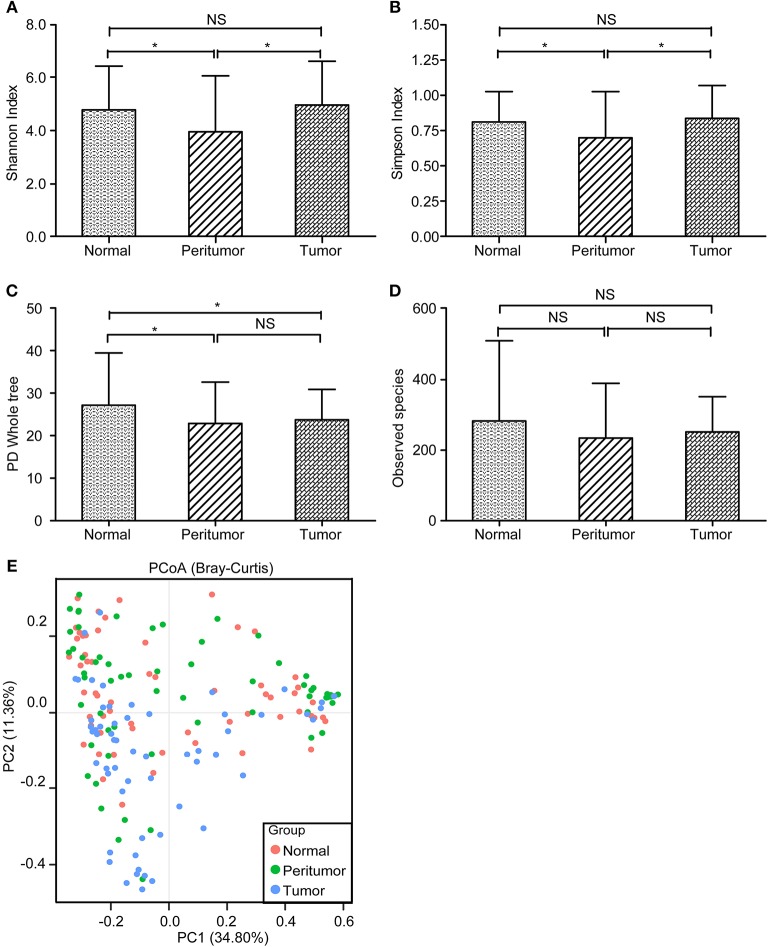
The diversity and richness of the gastric microbiota in different stomach microhabitats. Diversity indices such as Shannon (A) and Simpson (B), and richness indices, such as PD whole tree (C) and observed species (OTU number, D), were used to evaluate the overall structure of the gastric microbiota in the three stomach microhabitats. The data are presented as the mean ± standard deviation. Unpaired t-tests (two-tailed) were used to analyze variation among the three stomach microhabitats. Principal coordinate analysis (PCoA) plots of individual gastric mucosal microbiota based on Bray-Curtis distance (E). Each symbol represents a sample. *p < 0.05; NS, no significant.